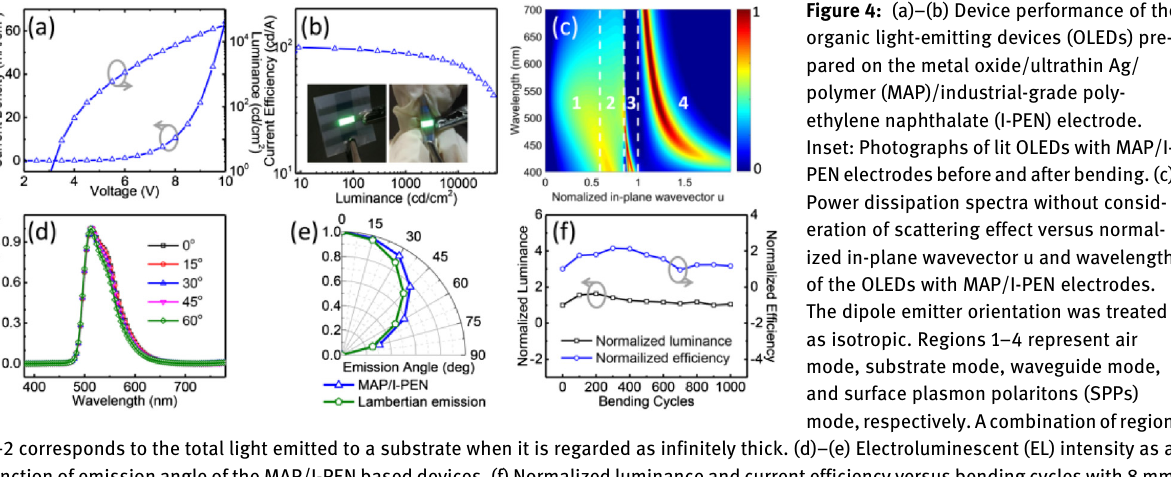
Figure 4: (a) – (b) Device performance of the organic light-emitting devices (OLEDs) pre- pared on the metal oxide/ultrathin Ag/ polymer (MAP)/industrial-grade poly- ethylene naphthalate (I-PEN) electrode.